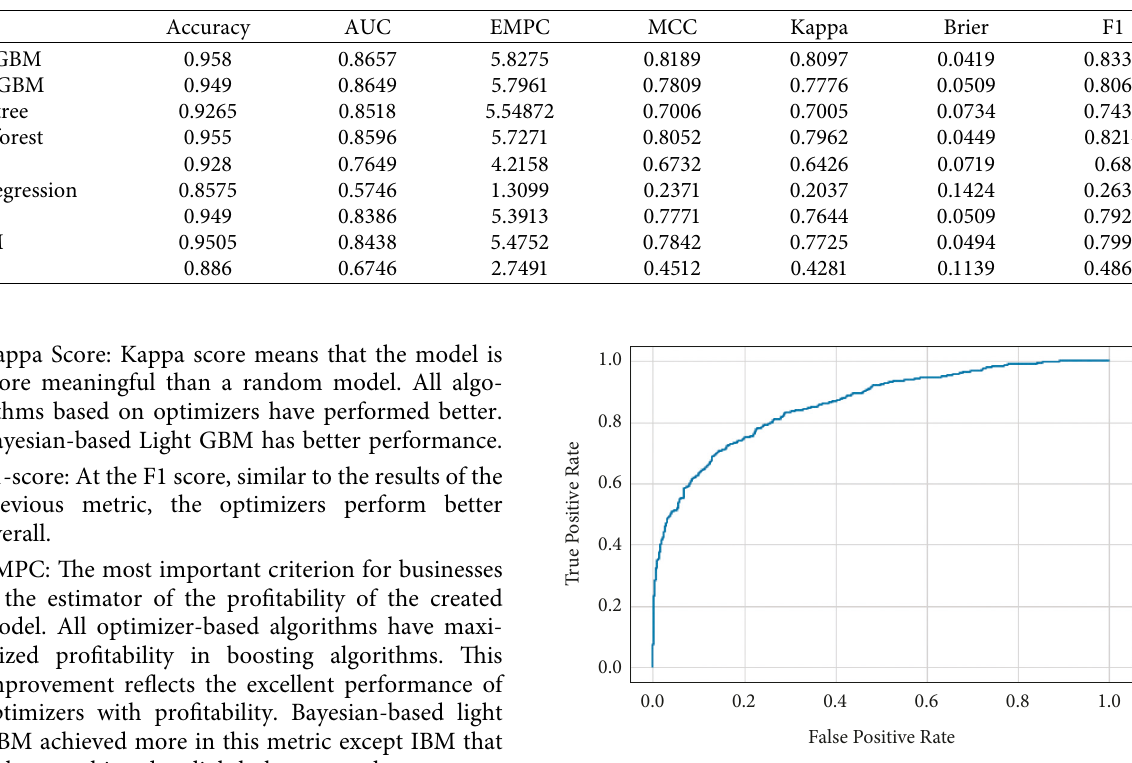
Table 12: Evaluation result of orange dataset.